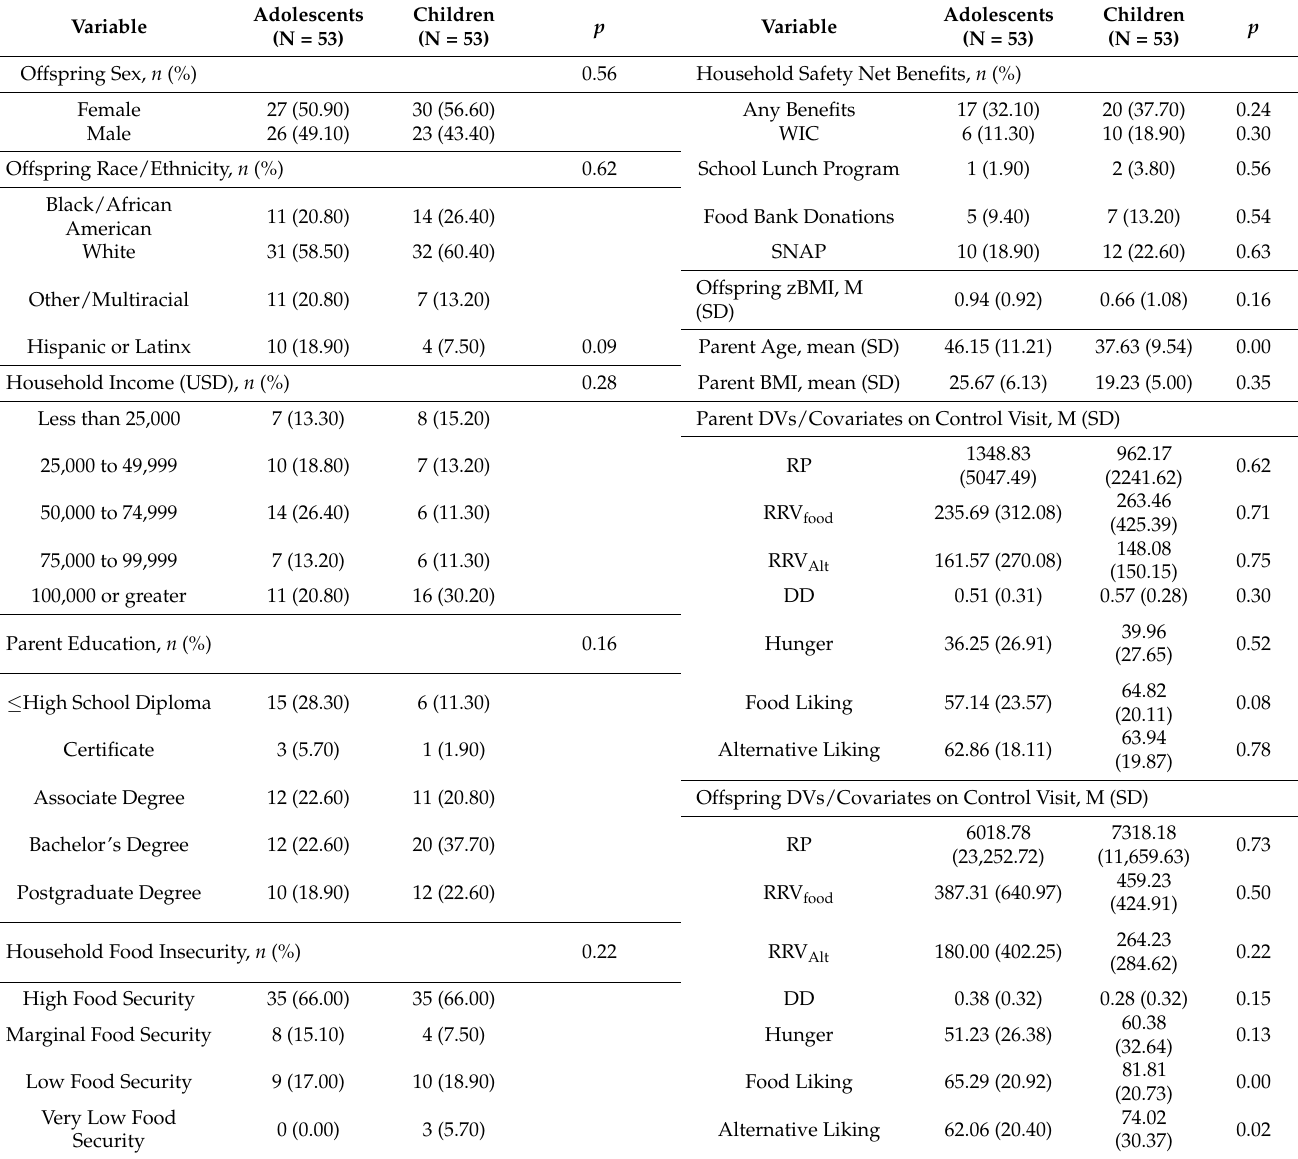
Table 1. Sample Characteristics (N = 106